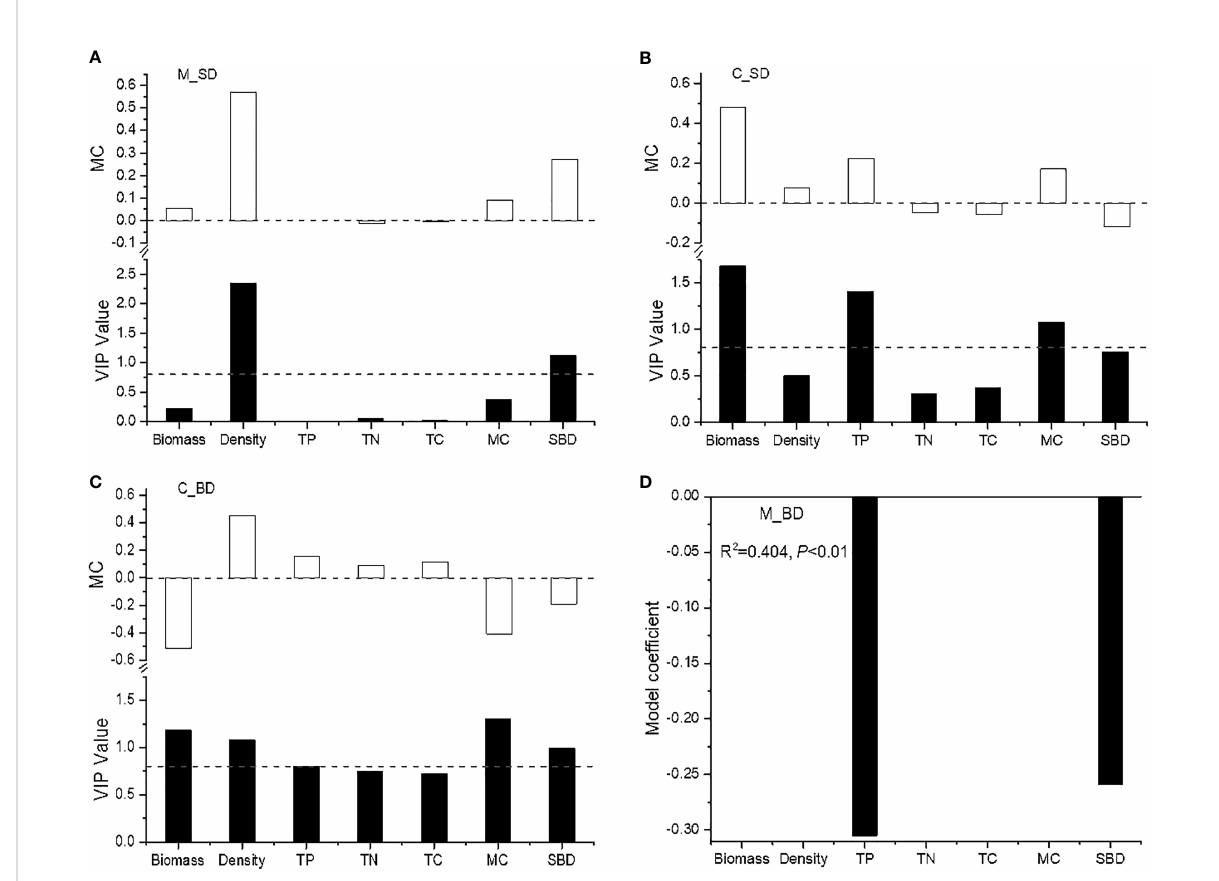
FIGURE 3 The regression models between seed/bud density and environmental factors. C_SD, seed density of Carex brevicuspis ; C_BD, bud density of C. brevicuspis ; M_SD, seed density of Miscanthus sacchari fl orus ; M_BD, bud density of M. sacchari fl orus. TP, total phosphorus; TN, total nitrogen; TC, total carbon; MC, moisture content; SBD, soil bulk density. (A) seed density of M. sacchari fl orus ; (B) seed density of C. brevicuspis ; (C) bud doldensity of C. brevicuspis ; (D) bud density of M. sacchari fl orus